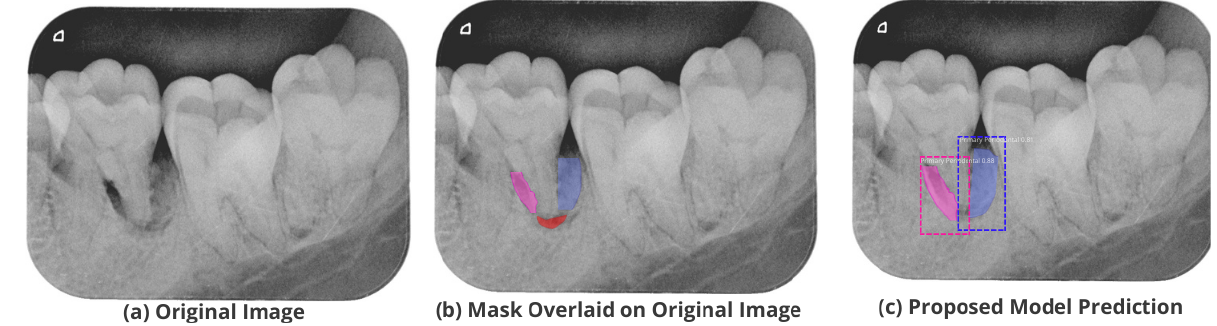
Figure 13. Test performance for the localization of a ’Primary Periodontal’ lesion.